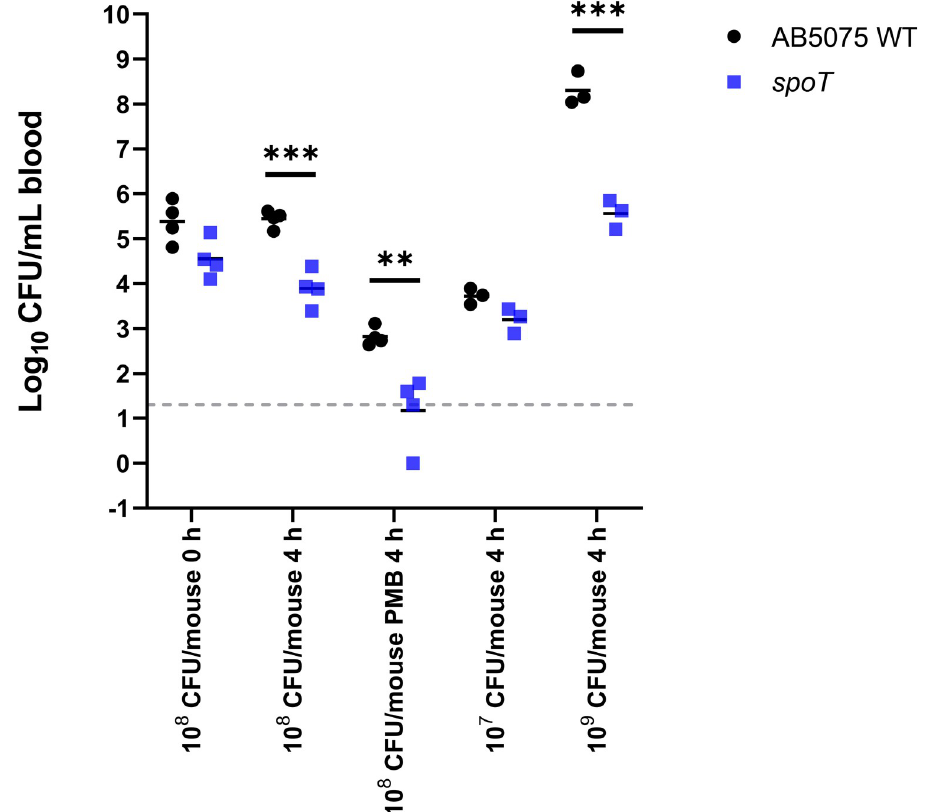
Fig 7. spoT mutant exhibits reduced virulence in vivo . Bacterial load of AB5075 wild-type (WT) and spoT mutant in blood in a mouse bacteremia model with and without polymyxin B (PMB) treatment (4 mg/kg, intravenous). At least three biological replicates per experimental group were examined. Multiple unpaired t -tests, �� p < 0.01, ��� p < 0.001. Dashed line indicates the limit of